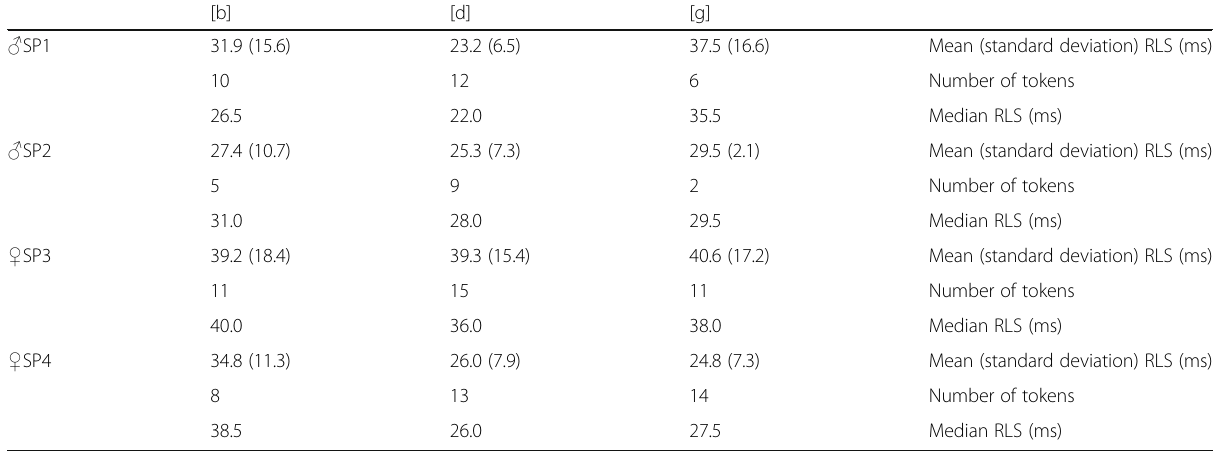
Table 5 Mean (standard deviation) RLS, number of tokens and median RLS